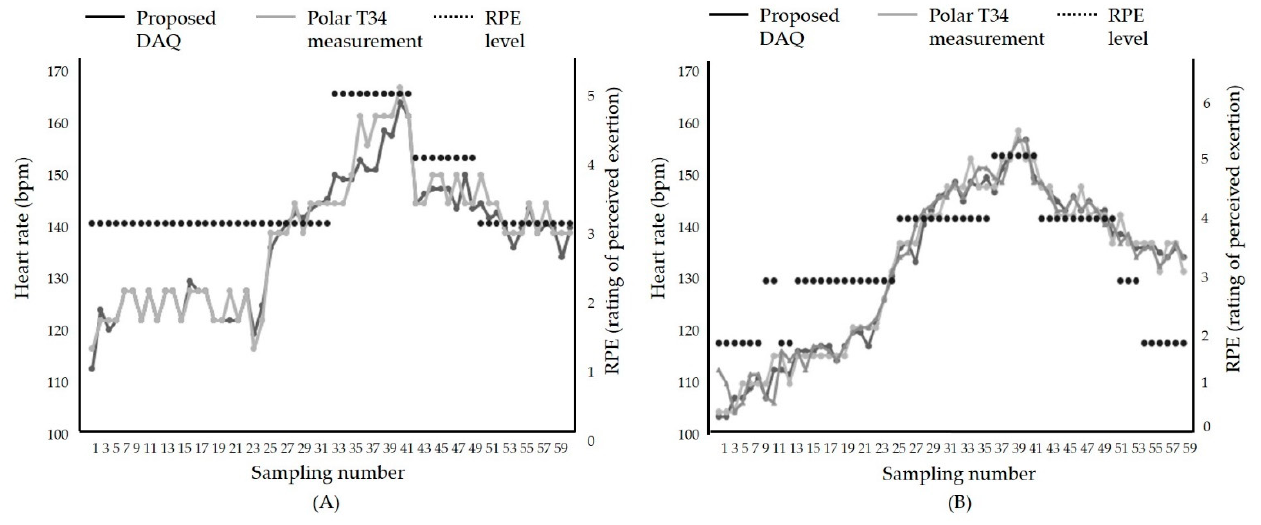
Figure 10. Comparison results between the heart rate during exercise using; ( A ) Treadmill, ( B ) stationary bike.